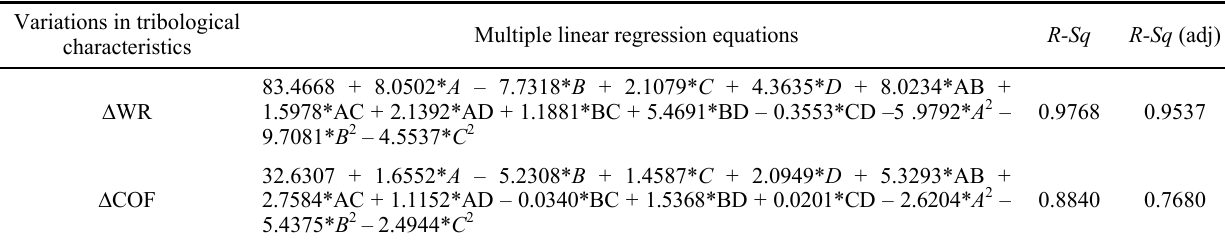
Table 6 Characteristic models based on coded linear regression equations. Variations in tribological characteristics